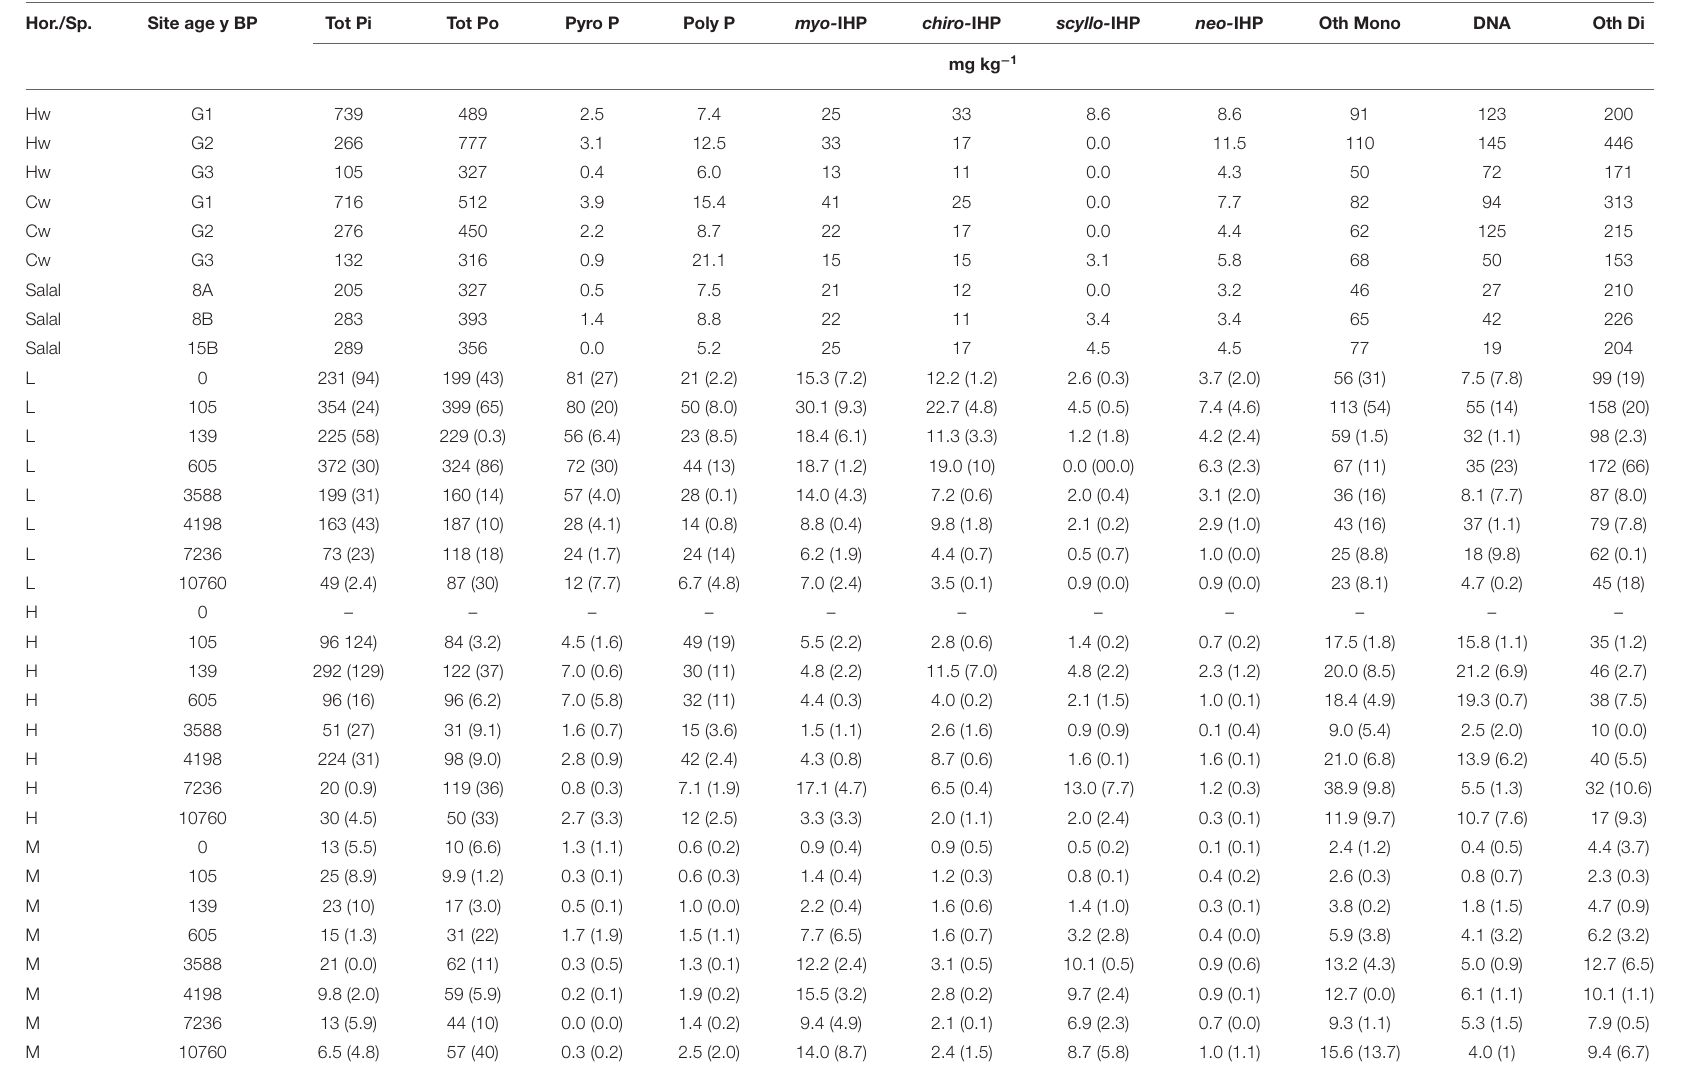
TABLE 4 | Concentration of P compounds within NaOH-EDTA extracts of soil (Hor) and composited foliage species (Sp.).